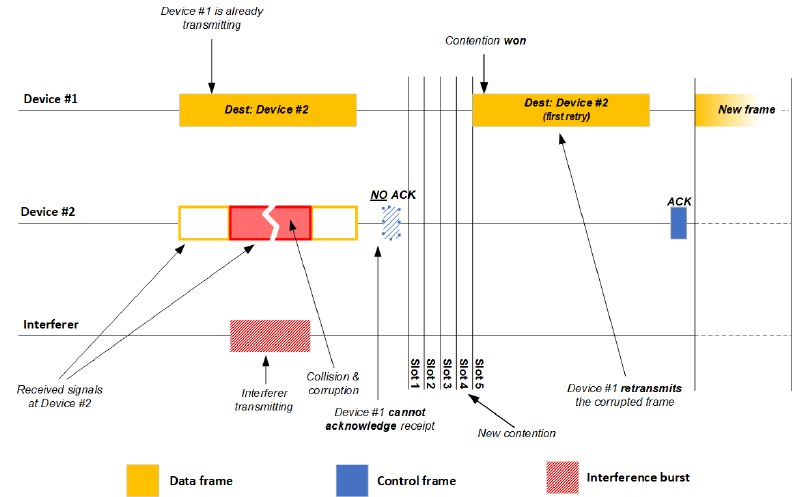
Figure 2. Illustration of CSMA/CA involving two devices and one interfering device on one channel of an IEEE 802.11 network in the presence of sporadic interference. ACK, Acknowledgment Control Frame; Dest, Destination.